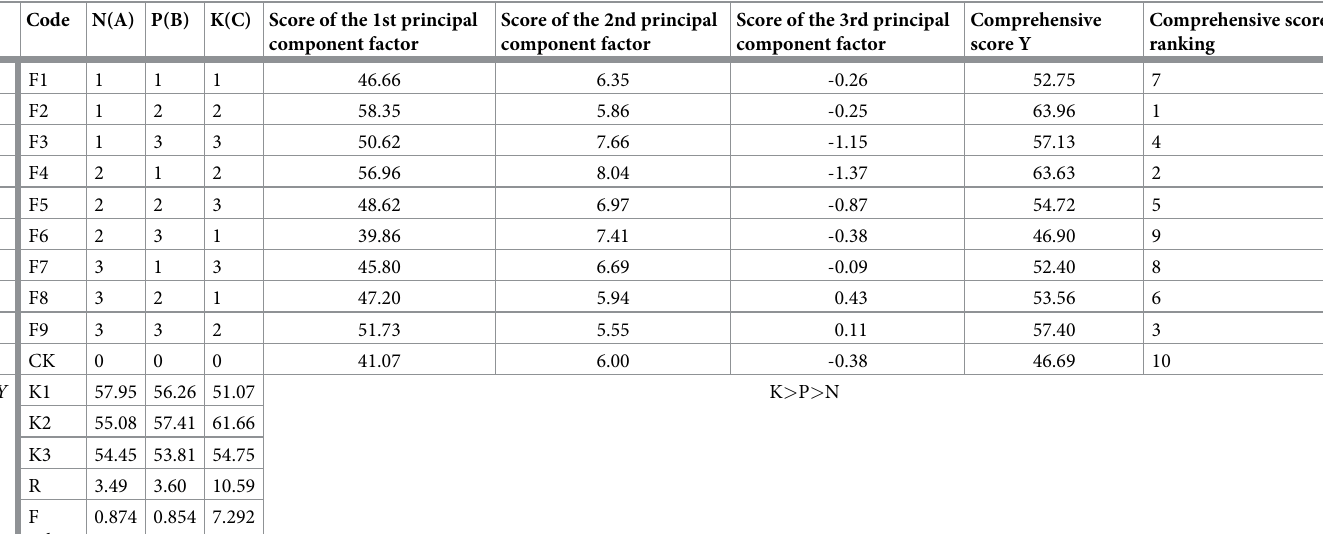
Table 6. Comprehensive score and ranking of yield and quality indexes of blueberry fruit under different fertilization treatments (2015). Code N(A) P(B) K(C) Score of the 1st principal component factor